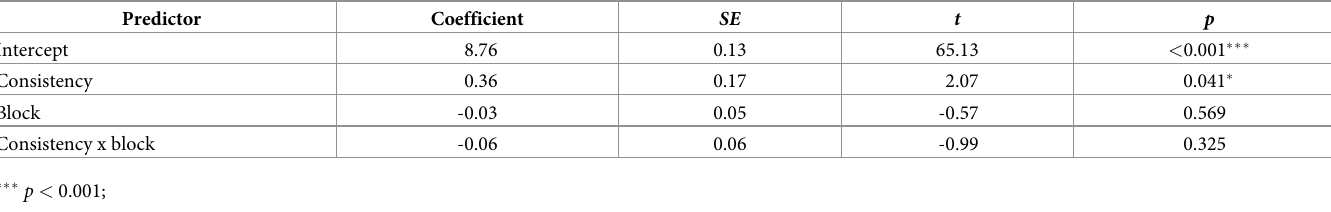
Table 3. Summary of the fixed effects in the mixed effect linear regression model incorporating test consistency, block, and their interaction for Experiment 2.